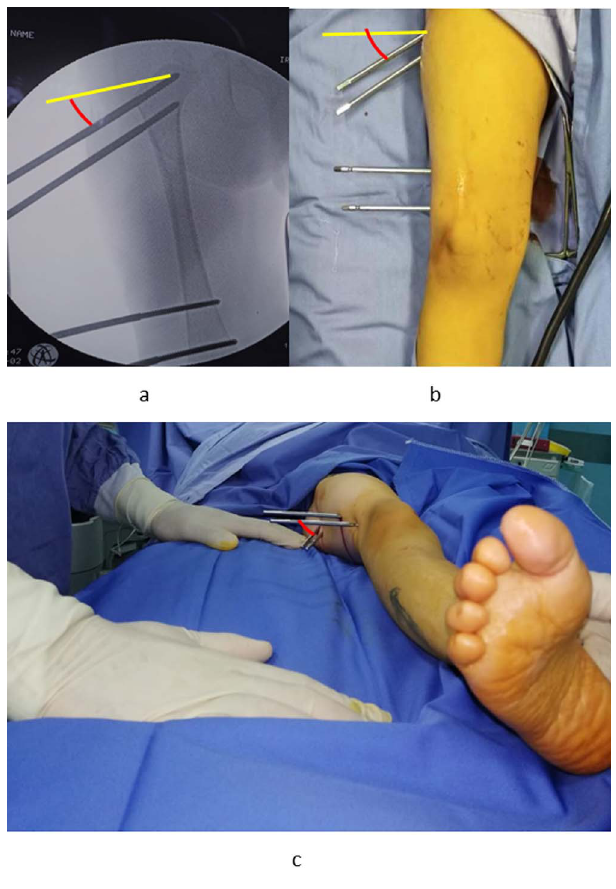
Figure 2. Distal pins insertion: Figure is depicting the diversion angle between proximal pins and distal pins in the frontal plane (a, b) and horizontal plane